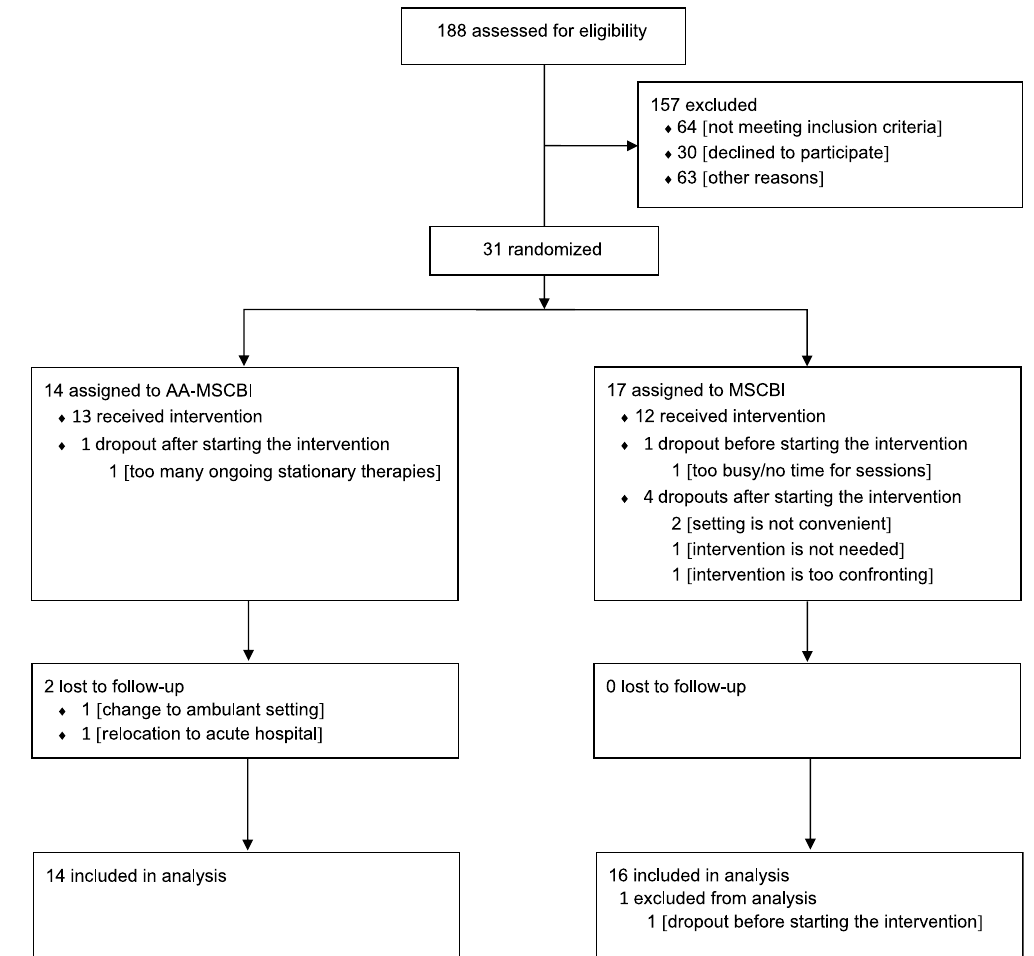
Figure 1. Patients flowchart for the animal-assisted psychotherapeutic mindfulness- and self-compassion- based group intervention (AA-MSCBI) and standard psychotherapeutic mindfulness- and self-compassion- based group intervention (MSCBI).